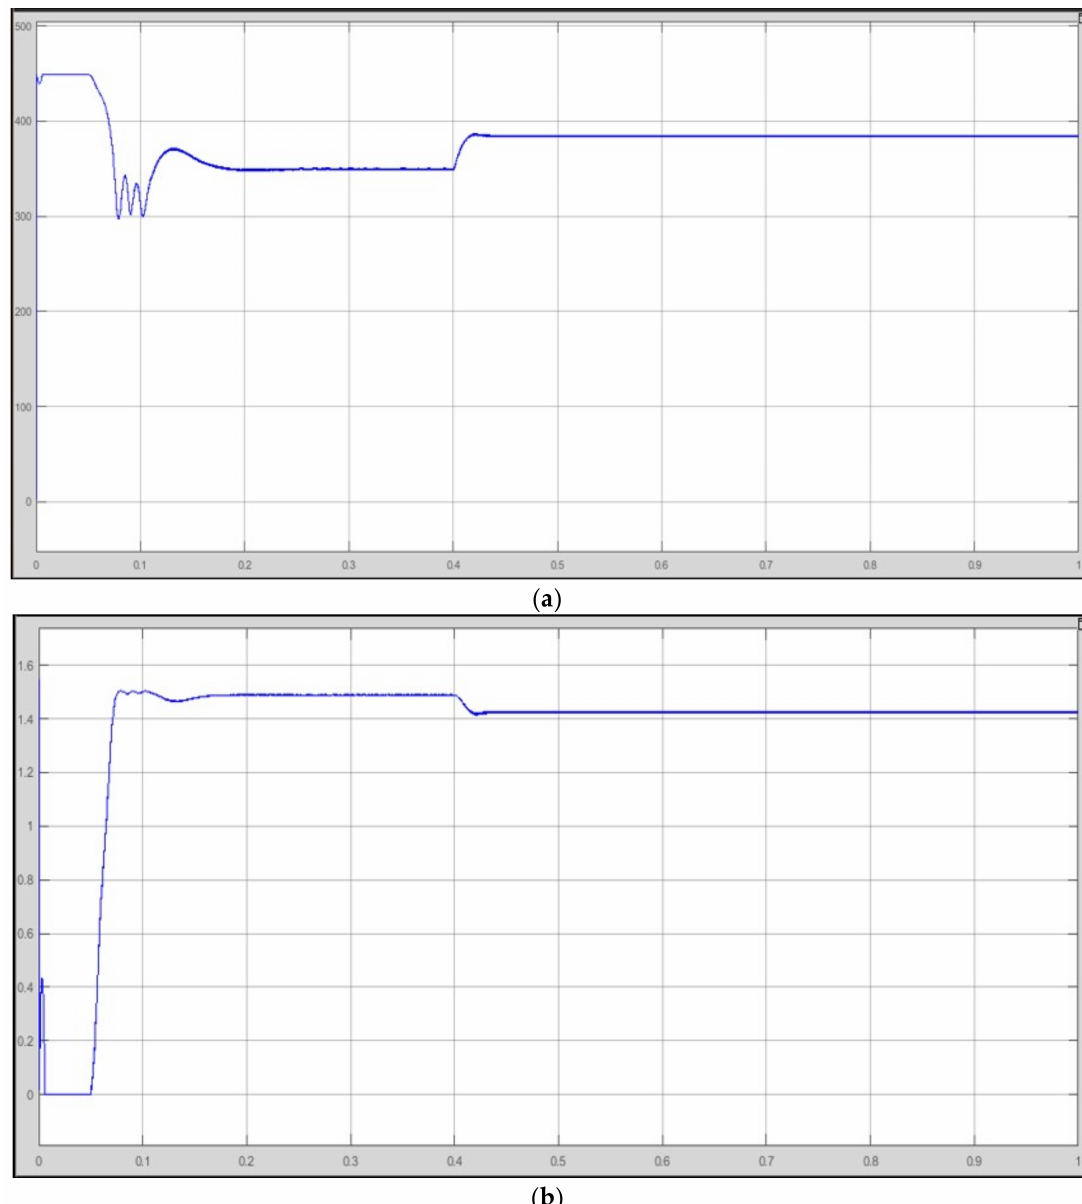
Figure 10. Performance of the high-gain converter: ( a ) voltage and ( b ) current. Figure 11 clearly denotes the voltage and current performance for the EV. This pro- posed structure correspondingly provided low swells in the resulting DC voltage. As a result, an insulated high-gain converter was exploited to confirm the good power quality features existing with the unity power factor. The proposed isolated converter topology was implemented and its performances were replicated in MATLAB with resistive load. The outcomes from the HGC were used to validate that topology and successfully enhanced the power quality features for definite